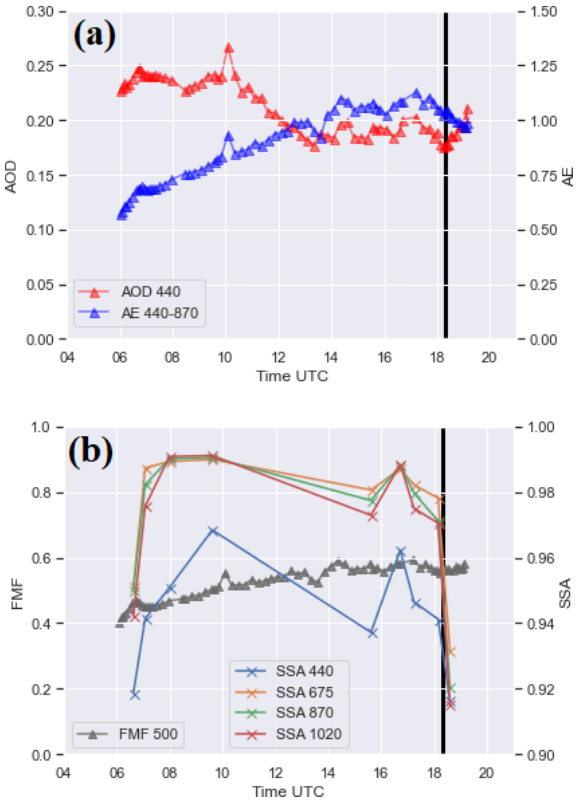
Figure 8. Sun-photometer data retrieved by AERONET at Évora on 28 June 2019 for (a) AOD 440 and AOD − AE 440–870 and for (b) the fine-mode fraction at 500nm (FMF 500 ) and the multiwave- length SSA daily series. The black vertical line indicates the Aeolus